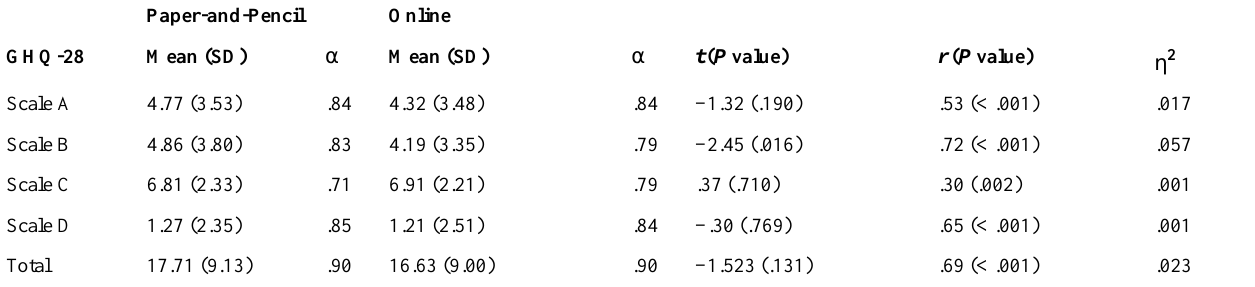
Table 2. GHQ-28 reliability results: Cronbach alpha, mean differences t test, Pearson test-retest correlation, and squared eta effect size